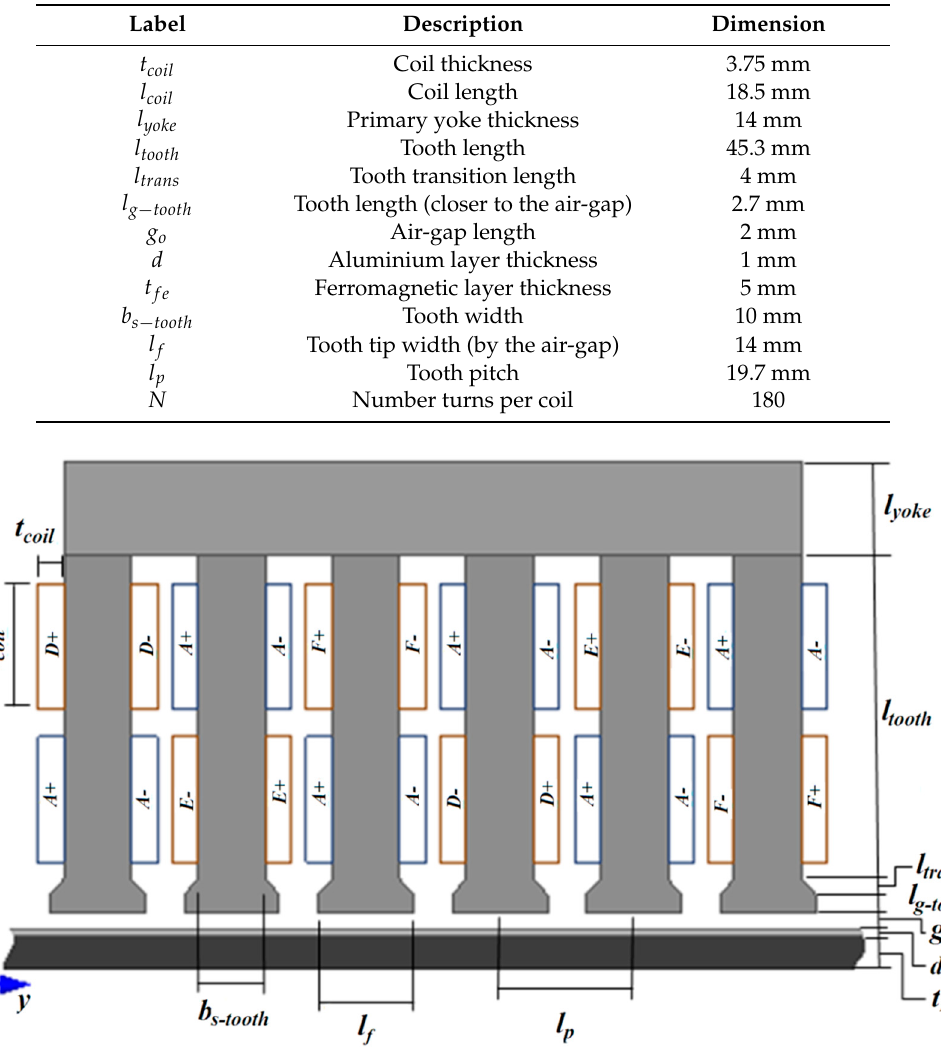
Figure 2. Construction dimensions of the induction planar actuator under study [11]. © 2015 IEEE. Reprinted, with permission, from IEEE Transactions on Magnetics.